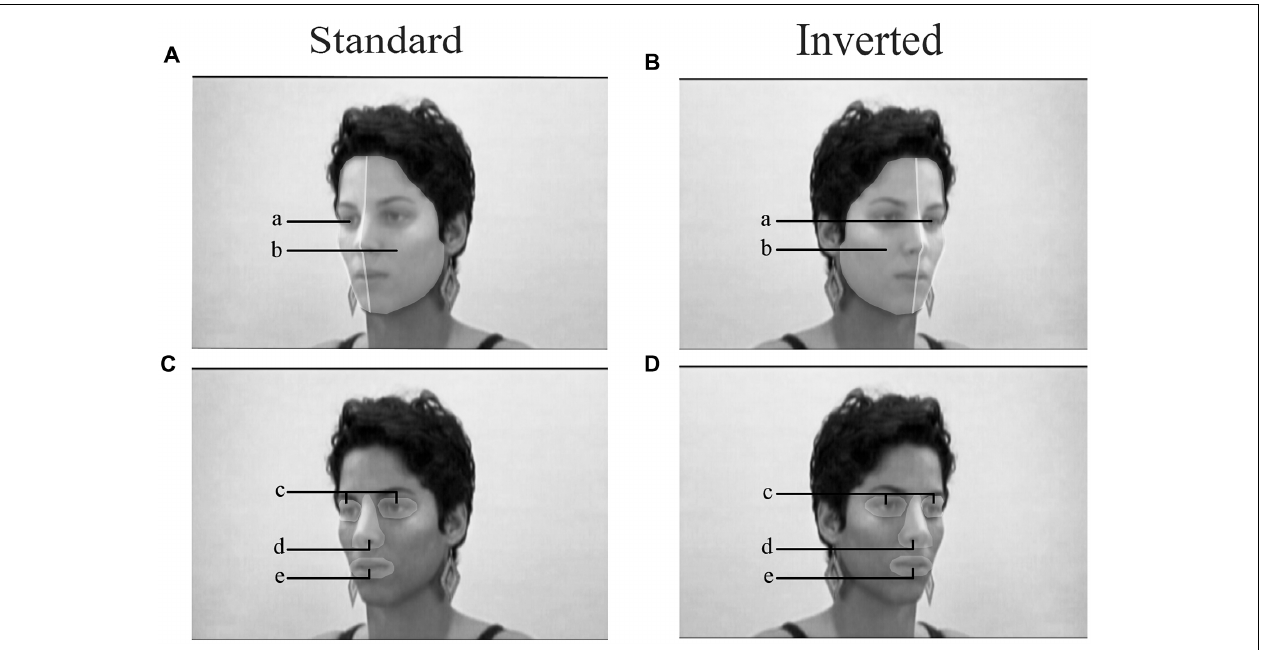
FIGURE 1 | The regions of interest (ROIs). Faces in standard orientation (A,C) and inverted (B,D) with ROIs defined as occluded hemi-face (a), exposed hemi-face (b), eyes region (c), nose region (d), mouth region (e). The variables of interest were extracted from ROIs and the three-way ANOVA was used with emotion as a between-groups